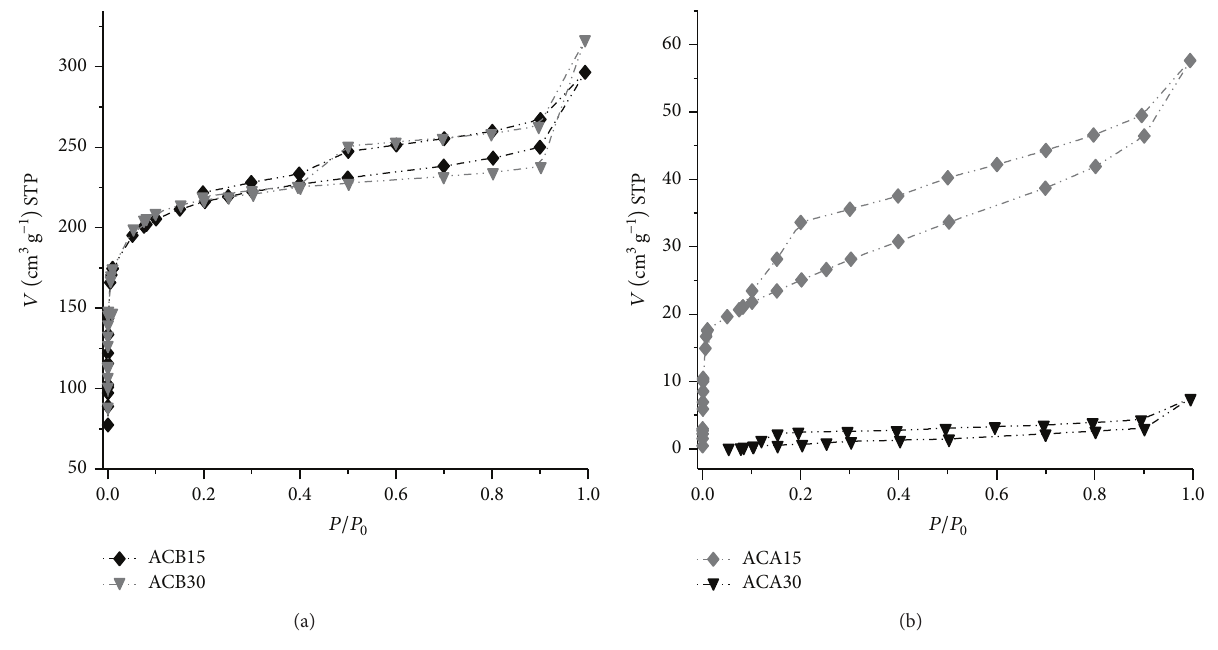
Figure 1: Nitrogen adsorption isotherms at 77 K of the